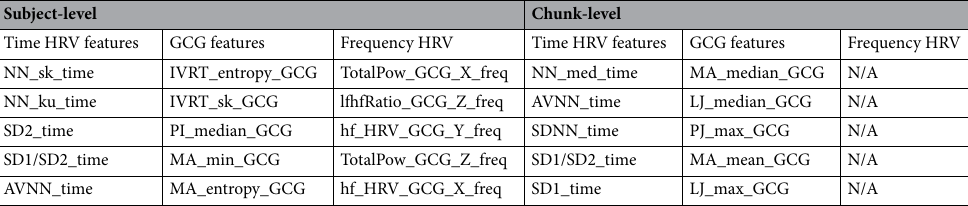
Table 6. Top-five features of ablation study by SHAP values.